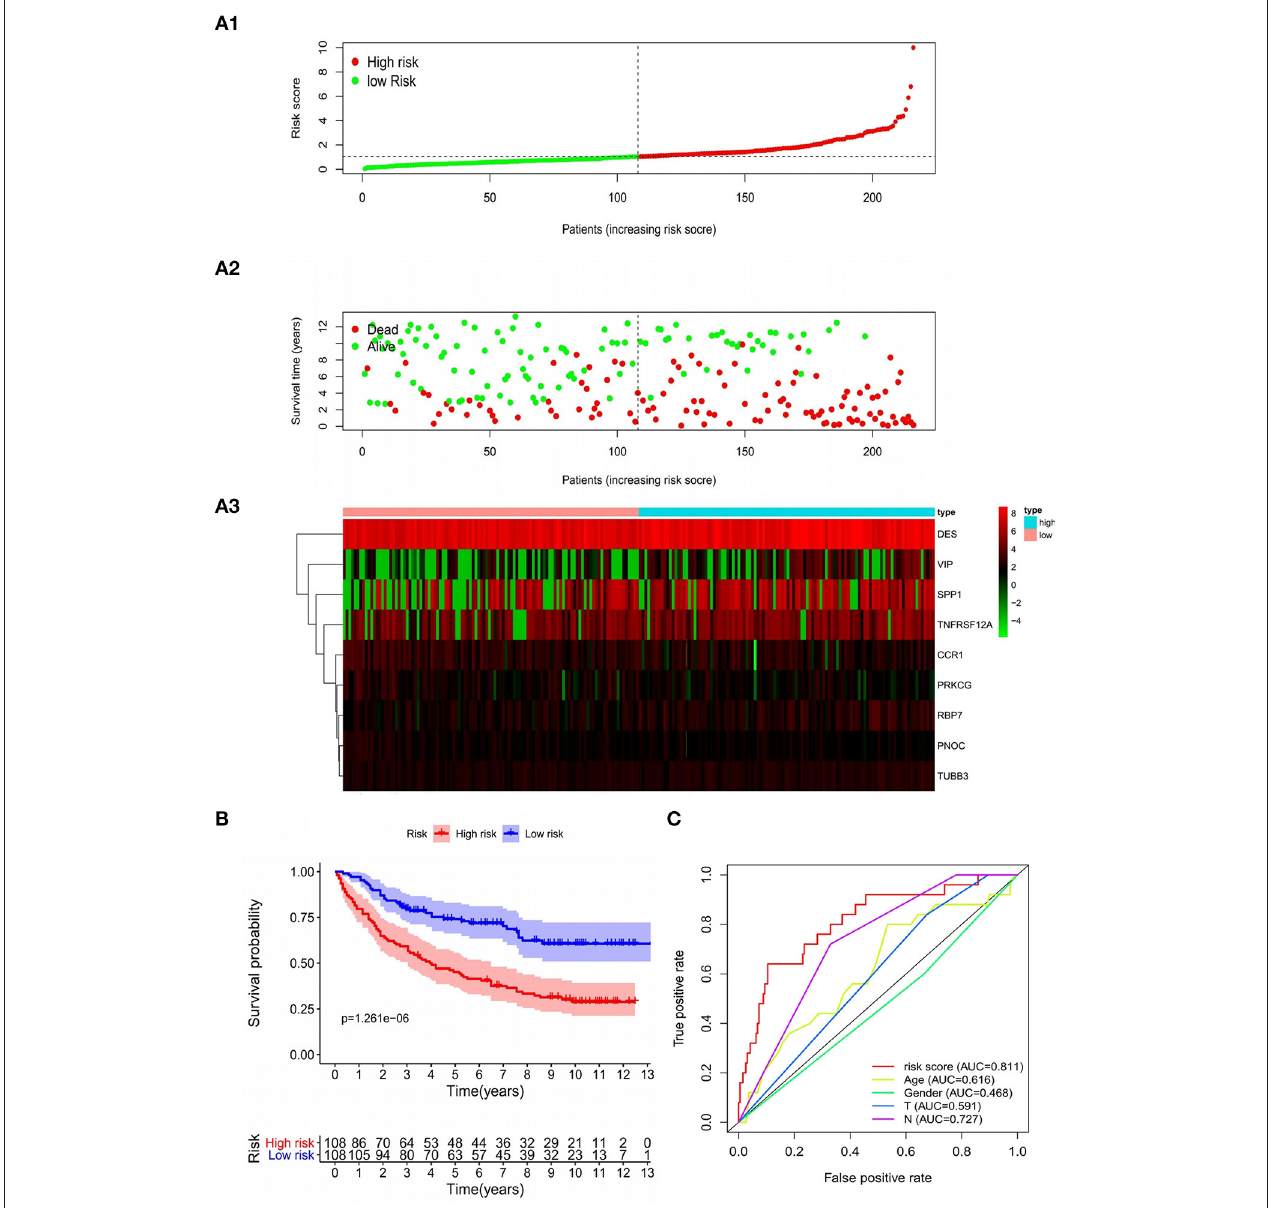
FIGURE 5 | Characteristics of the prognostic model in the training group. (A1,A2) The distribution of risk score, patients’ survival and status for GC. The black dotted line divided patients into high-risk group and low-risk group. (A3) Heat map of gene expression profiles in prognostic model for GC. (B) Kaplan-Meier survival analysis of patients stratified by the median risk score. (C) The ROC curve was applied to assess the predictive performance of the model compared to other clinical features.